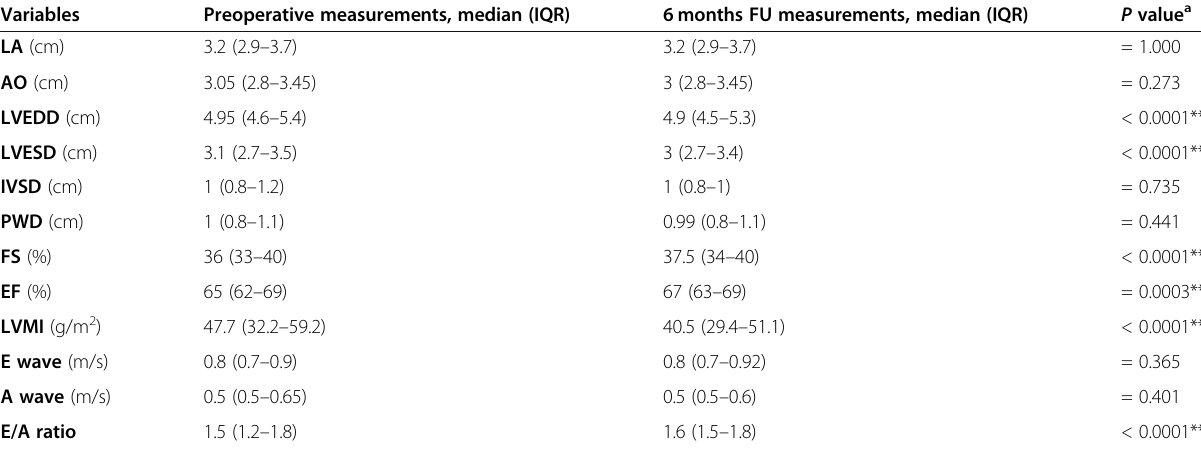
Table 4 Echocardiographic measurements preoperative and 6 months after bariatric surgery